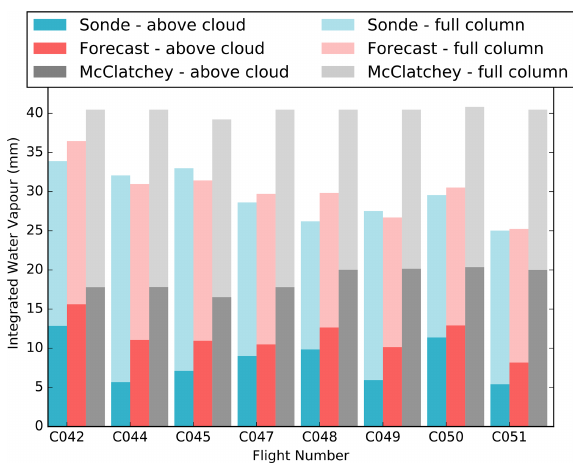
Figure 6. Comparison of the water vapour integrated over the full column (lighter shades) and above clouds (darker shades) from the dropsondes, the forecast and the McClatchey tropical atmospheric profile. For the McClatchey and the forecast, the top of the cloud is based on the cloud-top height retrieved by SEVIRI.